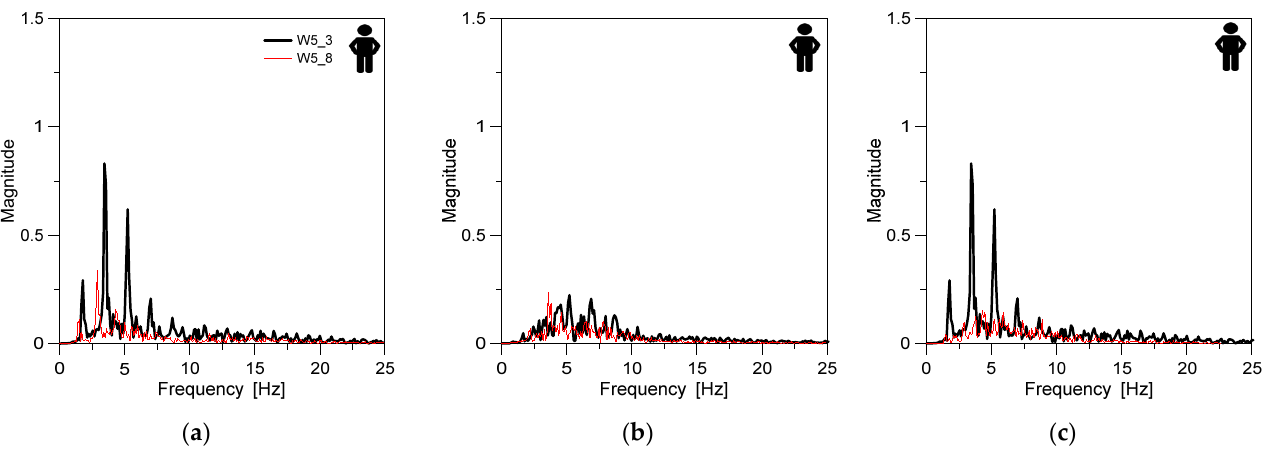
Figure 14. Analysis of experimental body CoM acceleration records (W5 selection) in terms of fast transform magnitude, with evidence of ( a ) vertical, ( b ) transversal, and ( c ) longitudinal components.